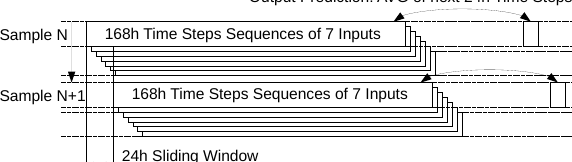
Figure 3. Sample format used for the set of DLNN models used in this